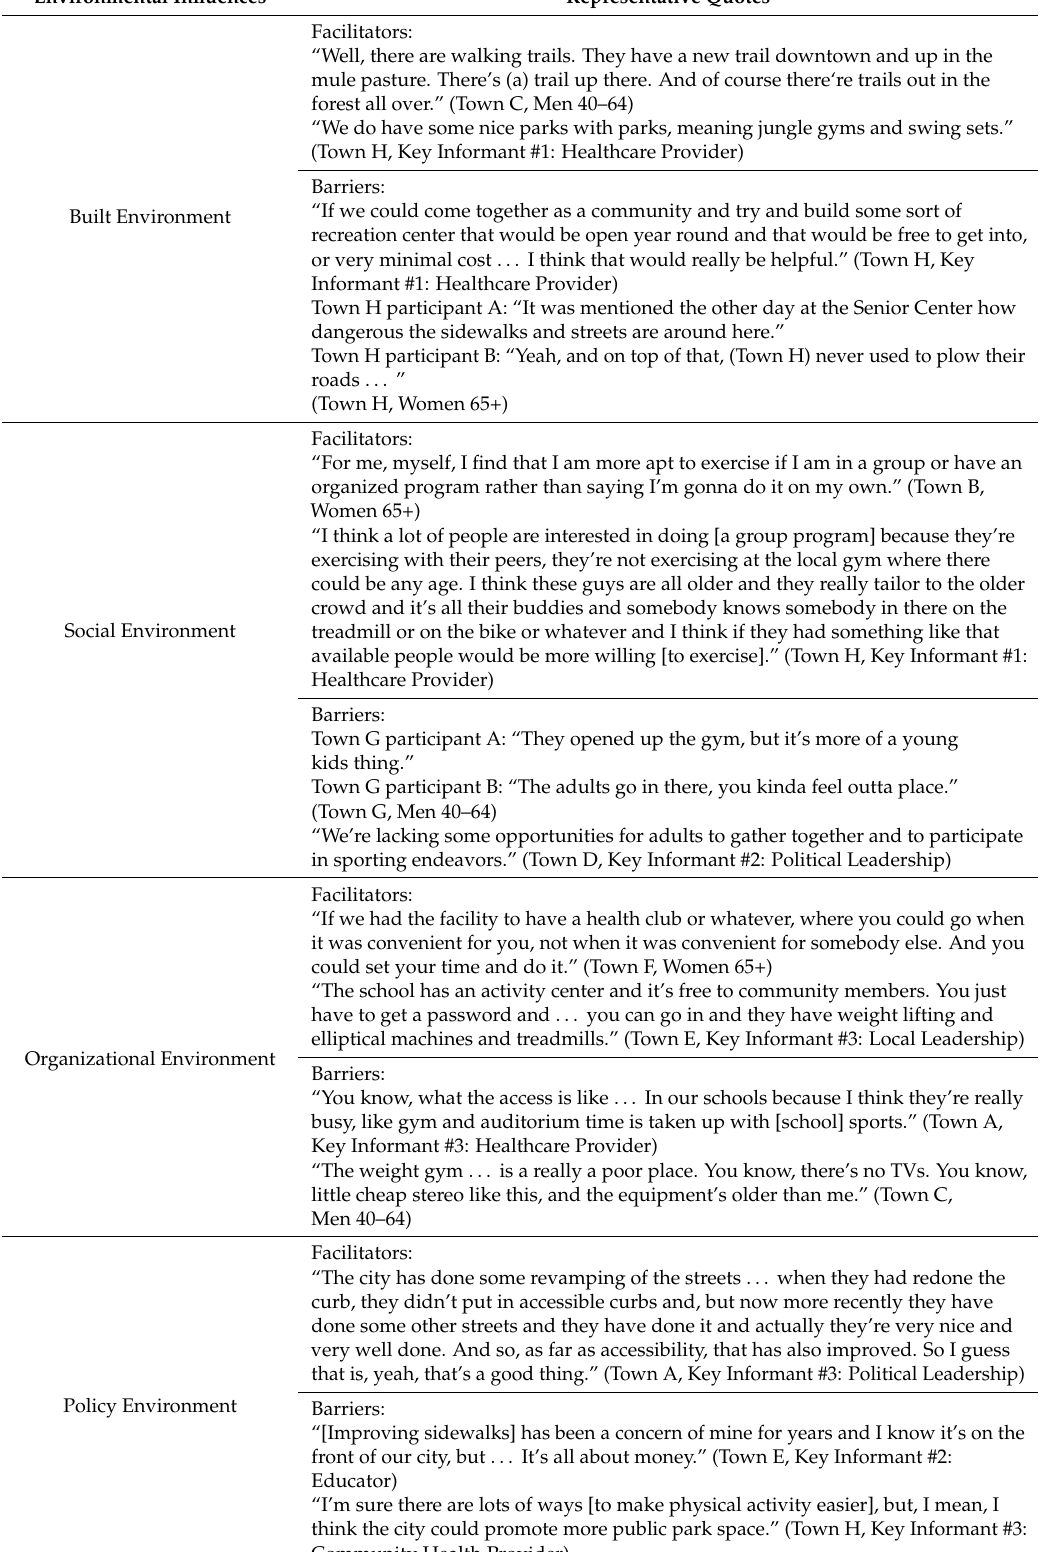
Table 4. Built, social, organizational, policy, and natural environment influences on physical activity